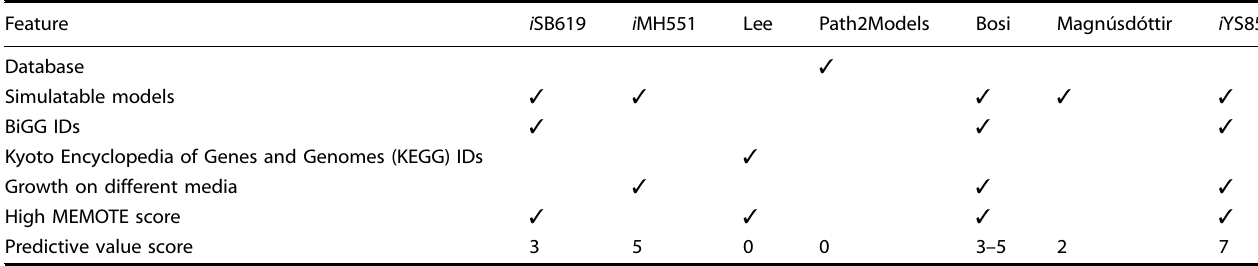
Table 2. Feature-based decision